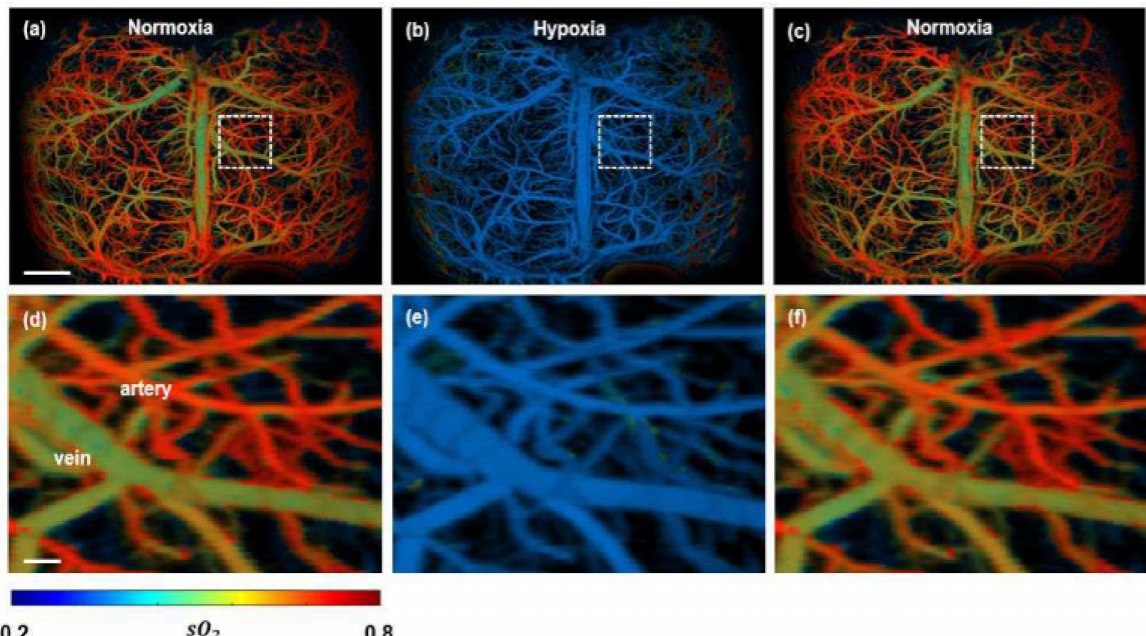
Figure 7. Functional PAM imaging of mouse brain hemodynamics under hypoxia. ( a – c ) sO 2 images of the whole mouse cortex following the cycle of normoxia → hypoxia → normoxia. ( d – f ) Zoomed images of the dashed box part in ( a – c ) [77].